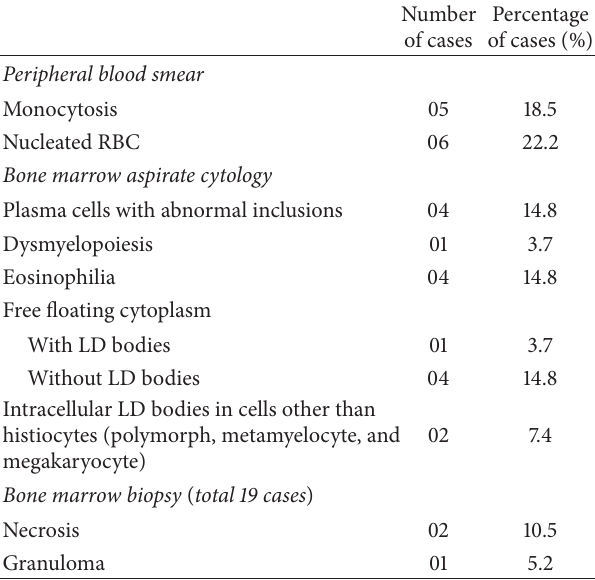
Table 3: Uncommon hematological and bone marrow findings observed in